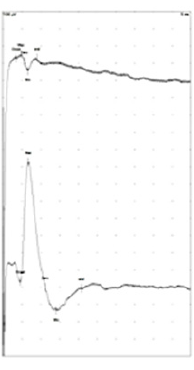
Figure 11. Compound motor action potential (CMAP) obtained after stimulation of the reinnervated facial nerve in the vicinity of the mandibular angle and recorded over the nasalis muscle (middle face). Notice the difference in amplitude; compared with the healthy side, the CMAP is quantifiable.